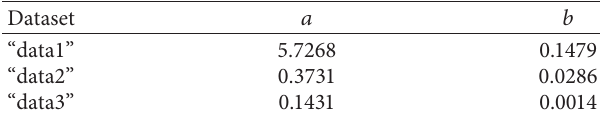
Figure 9: Amplitude vs. mean graph for “data3” ( Z Table 5: Linear tendency information y � ax + b coefficients a and b